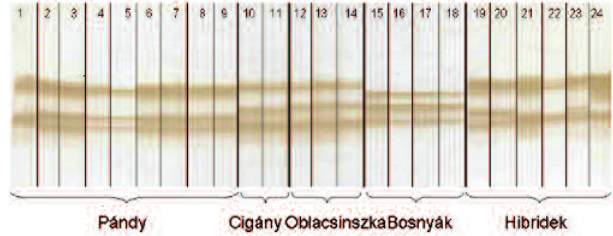
Figure 4. Silver stained microsatellite DNA profiles of the 24 investigated Hungarian sour cherry cultivars with primer pair PMS3 Table 4. Fragment lengths of the Hungarian sour cherry cultivars found in the USDA-ARS tart cherry SSR database. The fragments assigned with bold letters were not detected in the present study, while fragments assigned with bold and in italics were not included in the USDA-ARS tart cherry SSR database